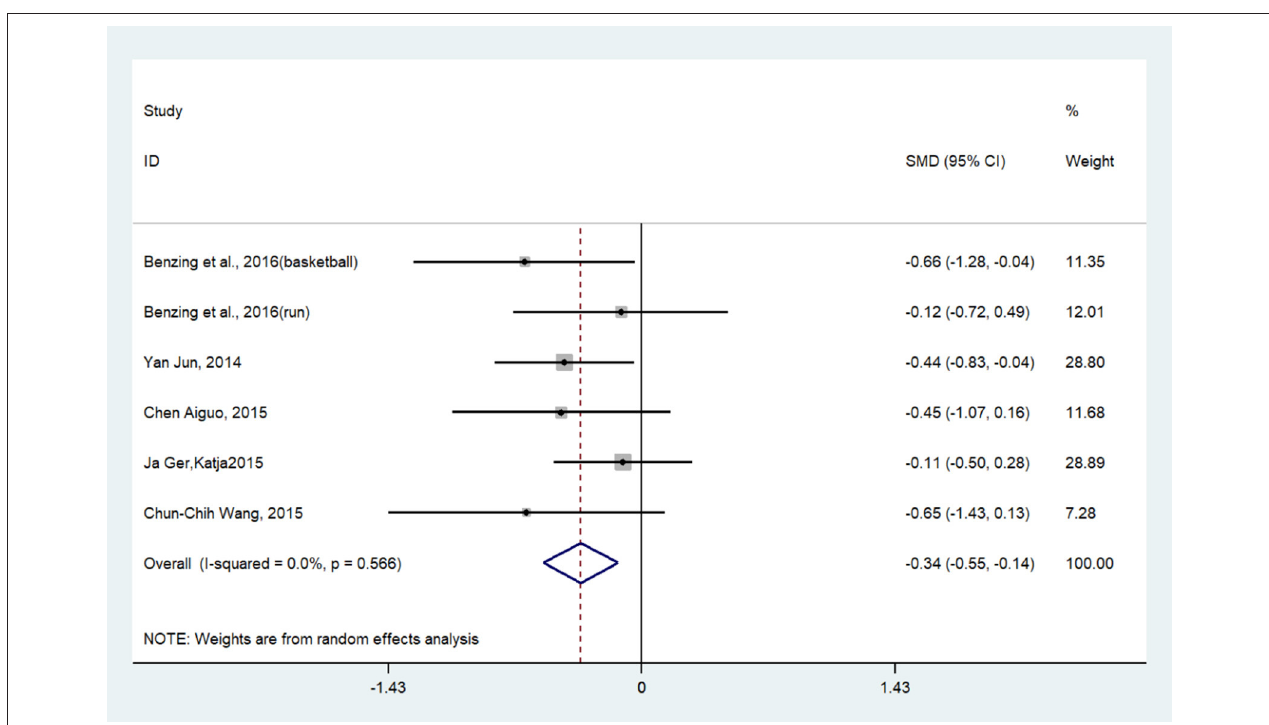
FIGURE 6 | The effect of acute exercises on cognitive flexibility (SMD = standardized mean difference; CI = confidence